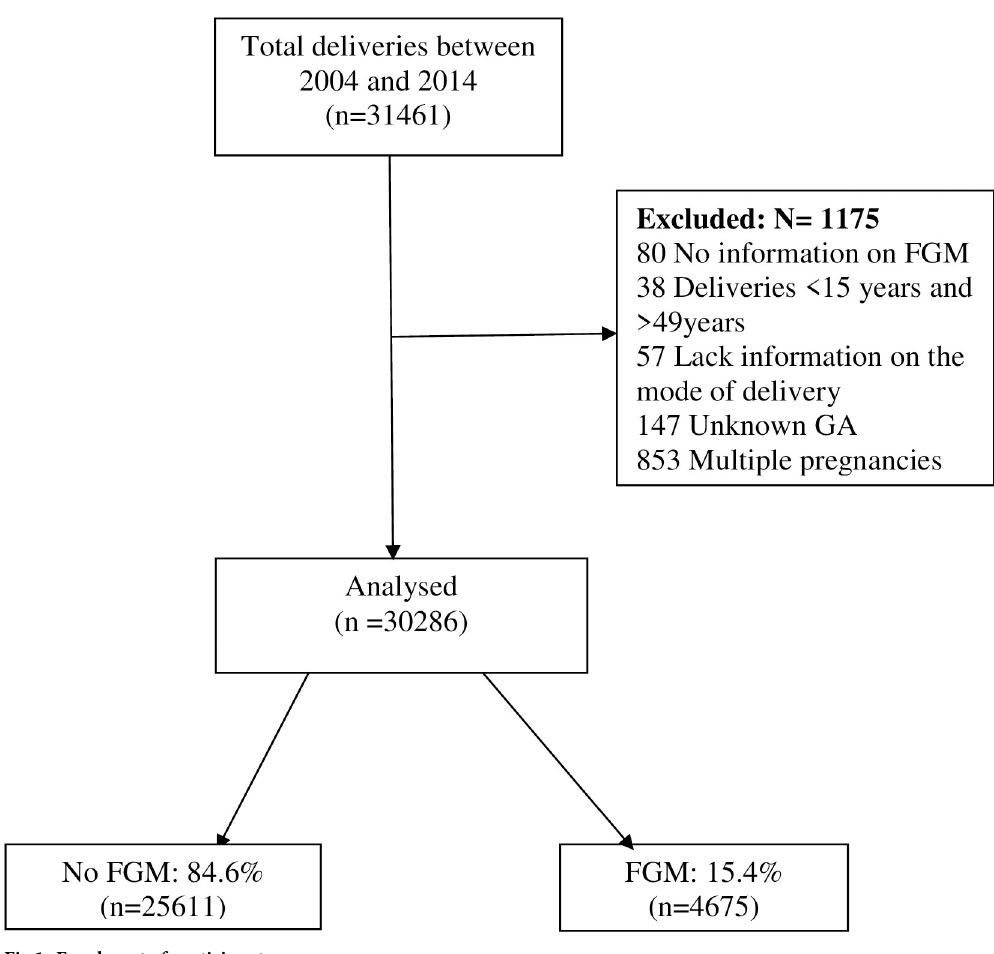
Fig 1. Enrolment of